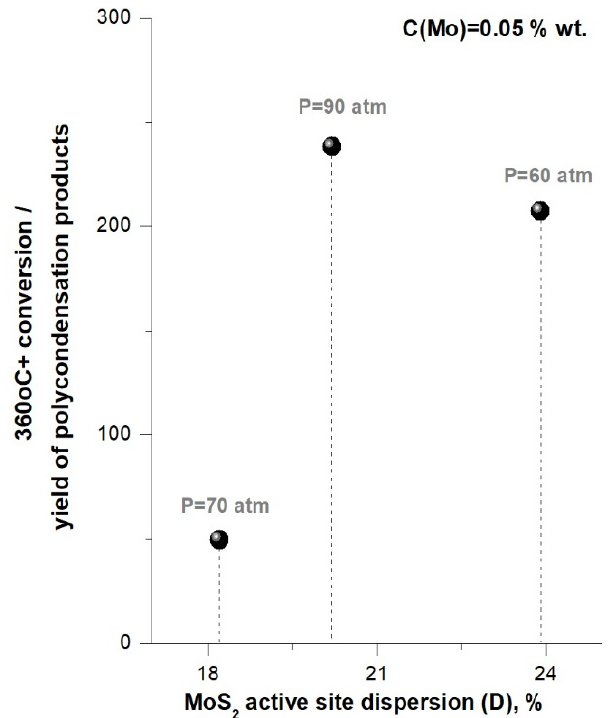
Figure 5. Dependence of the ratio « 360 °C+ conversion/polycondensation products yield» on catalyst active site dispersion in pressure variation tests.